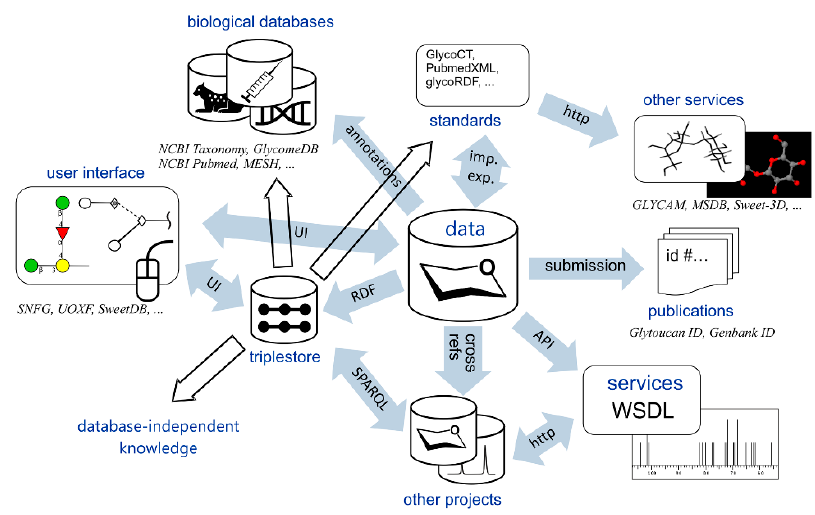
Figure 2. Networking between glycoinformatics projects and related services that promotes achievement of data integration in glycomics. Reproduced with permission from [29], © 2020 Wiley-VCH Verlag GmbH & Co. KGaA, Weinheim.